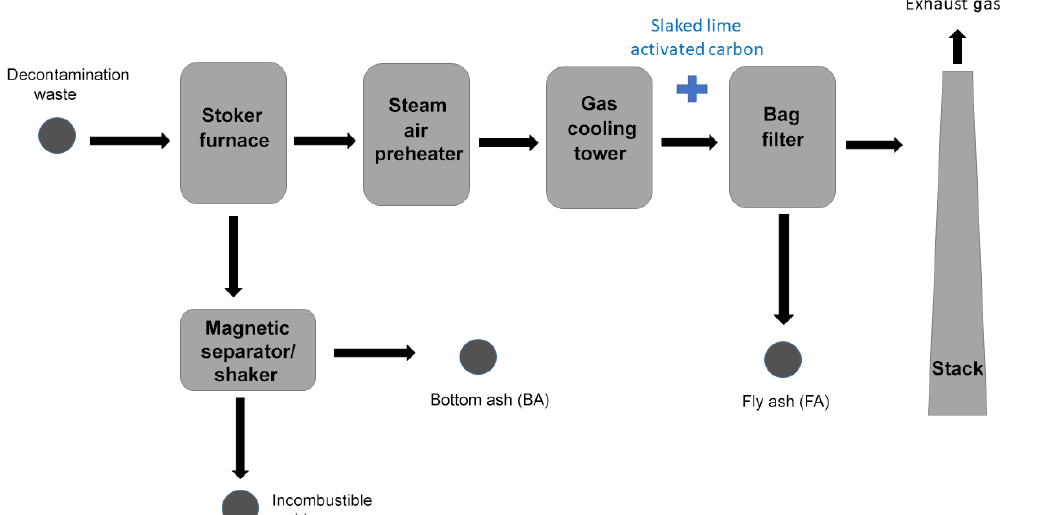
Figure 7. Simplified diagram showing the functioning of an incineration plant treating decontamination waste in Fukushima, modified after Parajuli et al. (2013) and Fujiwara et al.